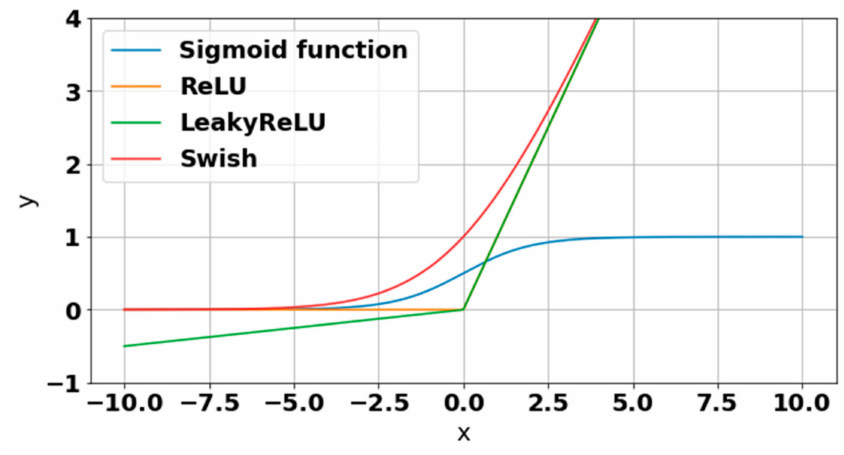
Figure 1. Plots of the new Swish activation function [26] compared to other activation